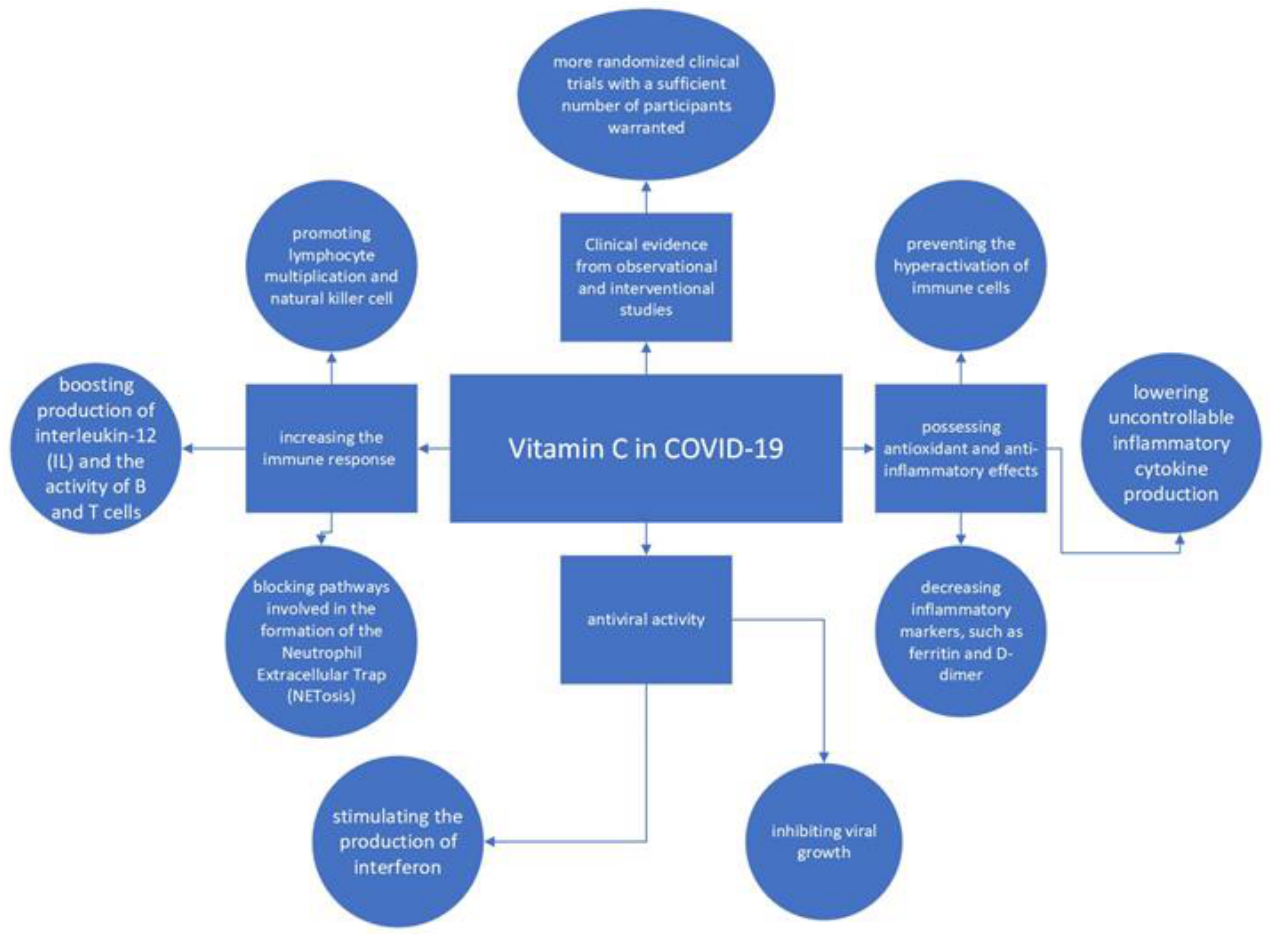
Figure 1. Vitamin C activities — summary.